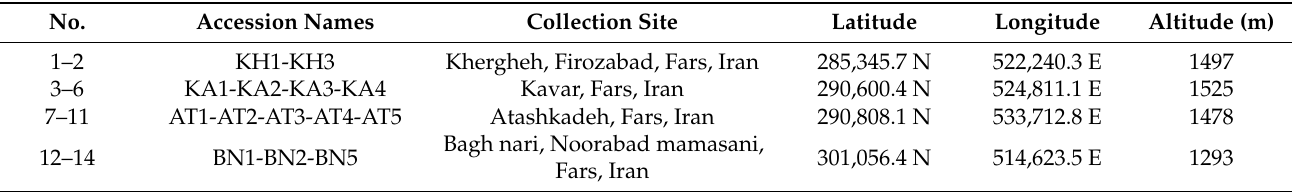
Table 2. Collection site and geographical characteristics of 14 superior myrtle accessions.